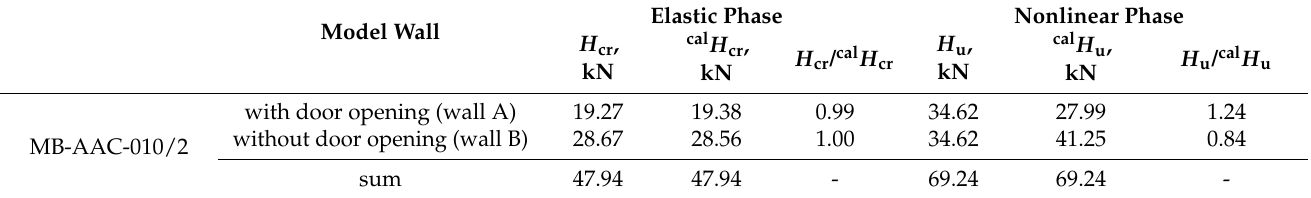
Table 9. Comparison of test results and analytical